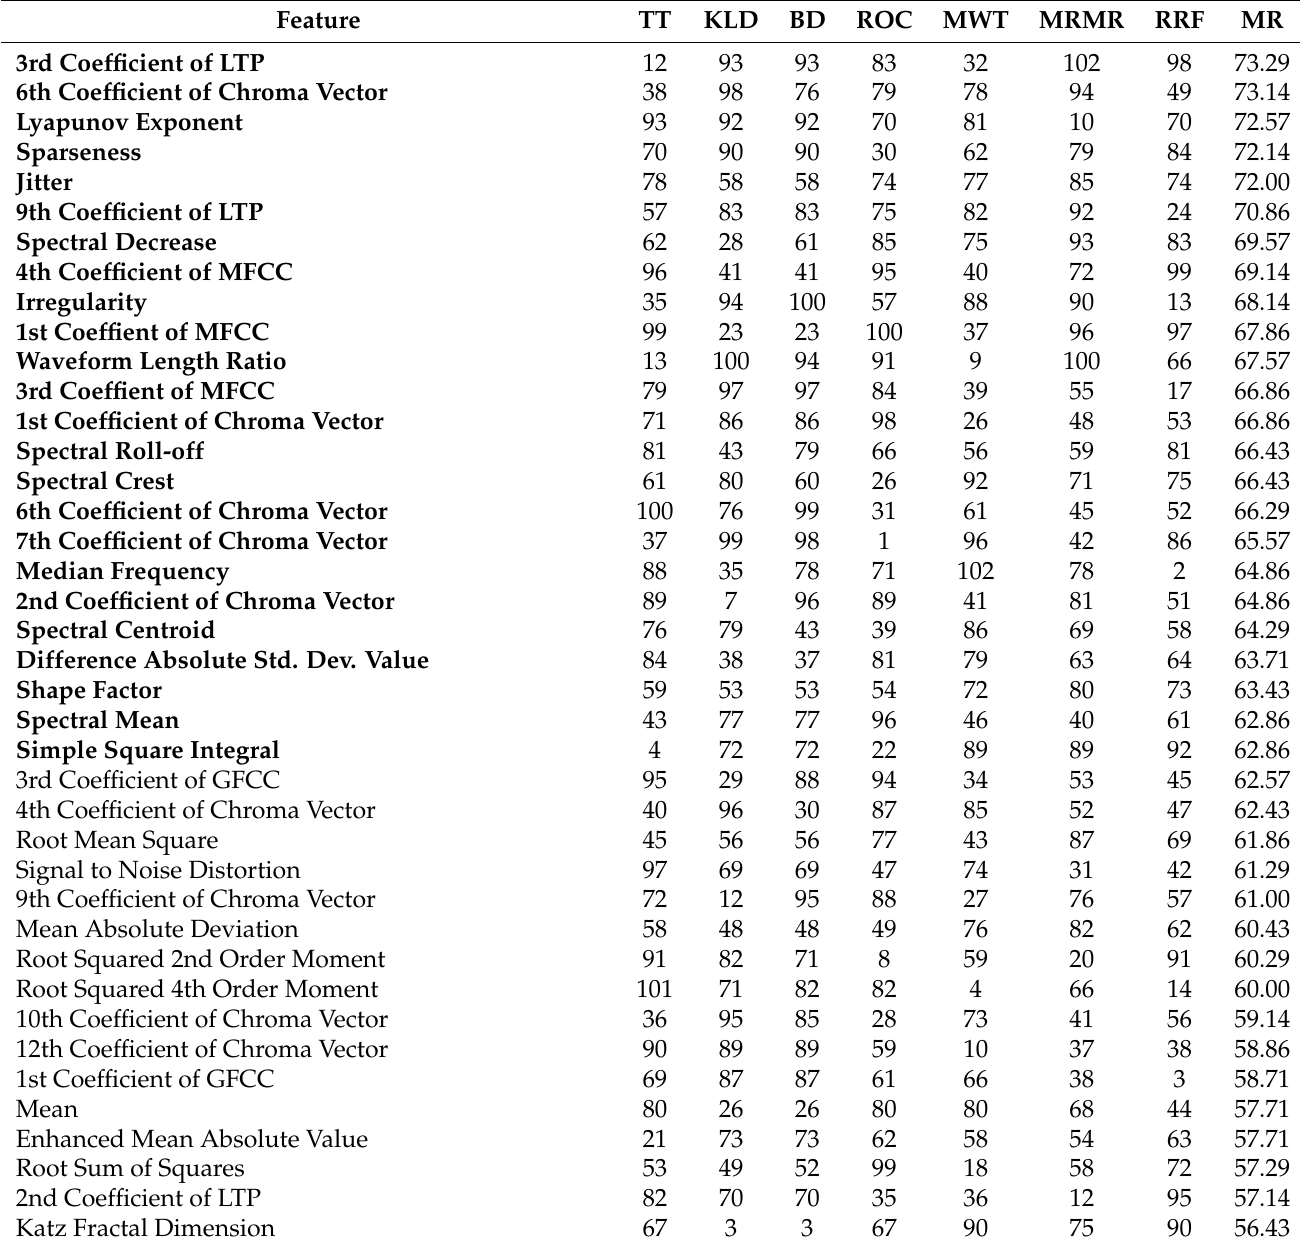
Table 7. List of features extracted for method I and sorted with respect to mean rank (MR) value. Bold font indicates the top 24 ranked